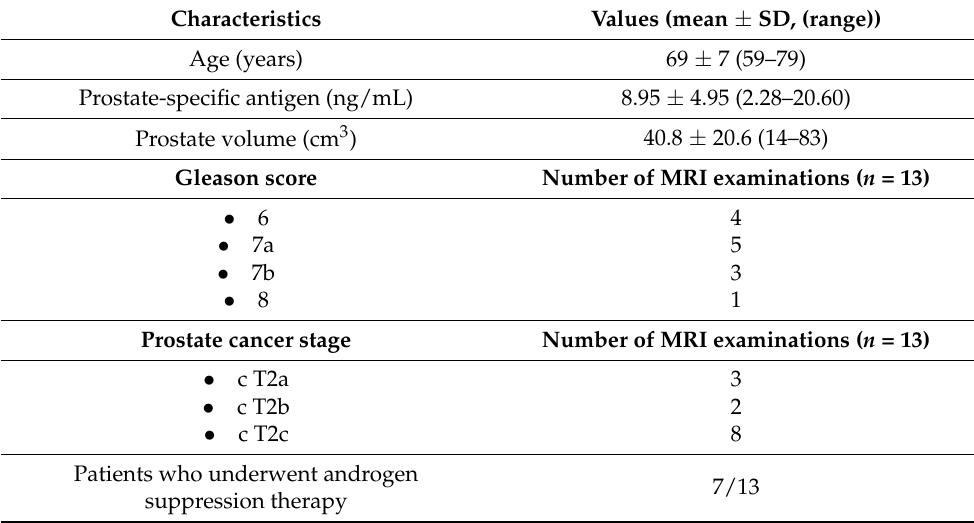
Table 2. Characteristics of the included